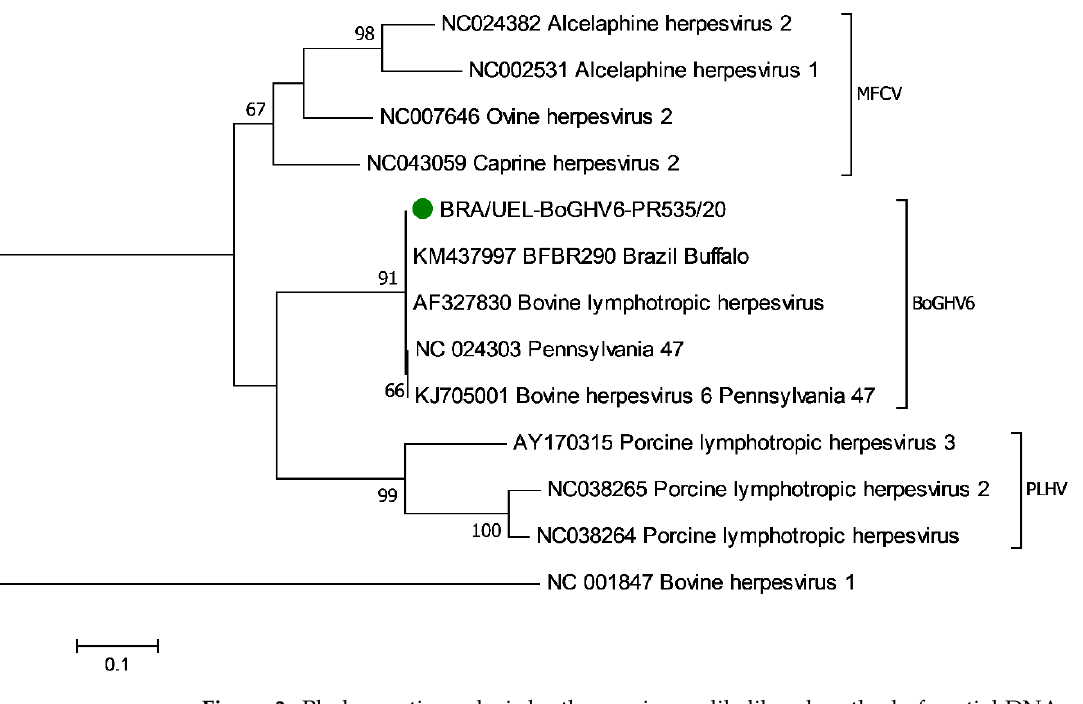
Figure 3. Phylogenetic analysis by the maximum likelihood method of partial DNA polymerase gene of members of the Macavirus genus. The evolutionary history was inferred by using the maximum likelihood method based on the Kimura 2-parameter model. The percentage of trees in which the associated taxa clustered together is shown next to the branches. The analysis involved strains of bovine herpesvirus 6 and representative members of each species of the Macavirus genus; bovine alphaherpesvirus 1 was used as the out-group. The BoGHV6 strain identified in this study is highlighted ( ● ).